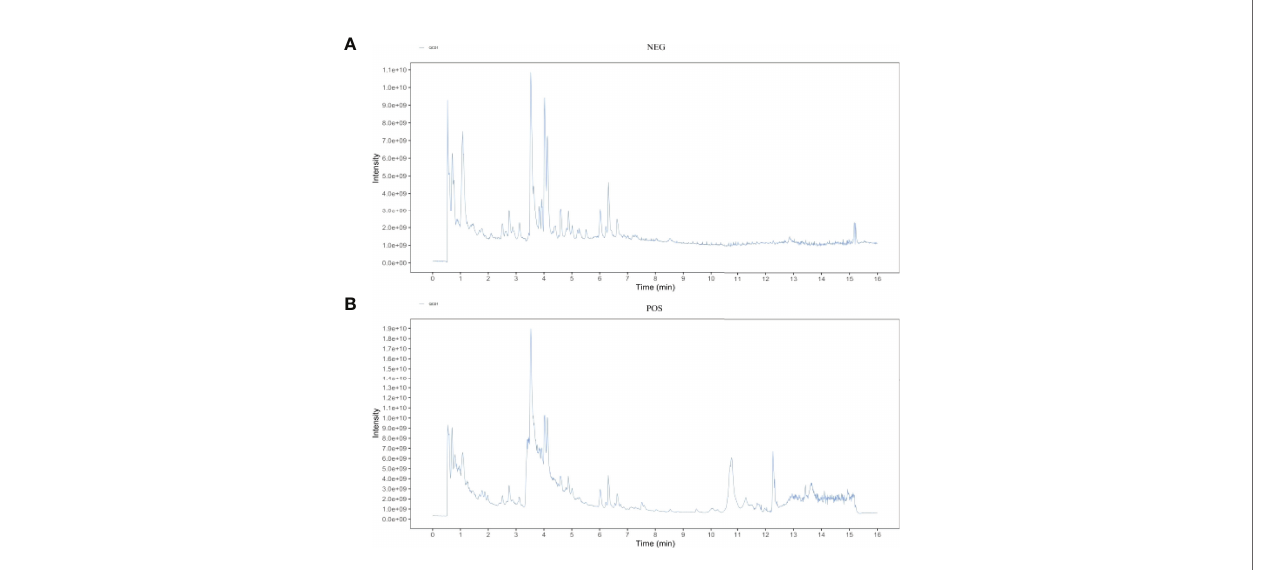
FIGURE 2 | Total ion chromatogram of the methanol extract acquired by UHPLC-QE-MS in the positive (A) and negative (B) ion